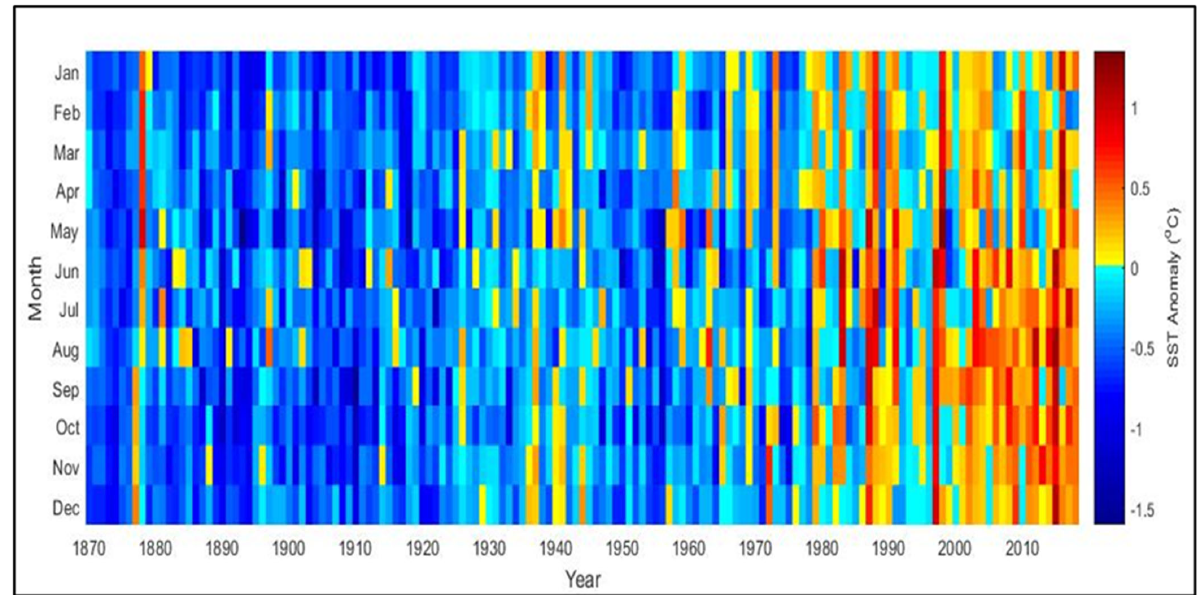
Figure 3. Long ‐ term variations of SST anomalies in all years and months in the Gulf of Mannar (GoM) from 1870 to 2018.